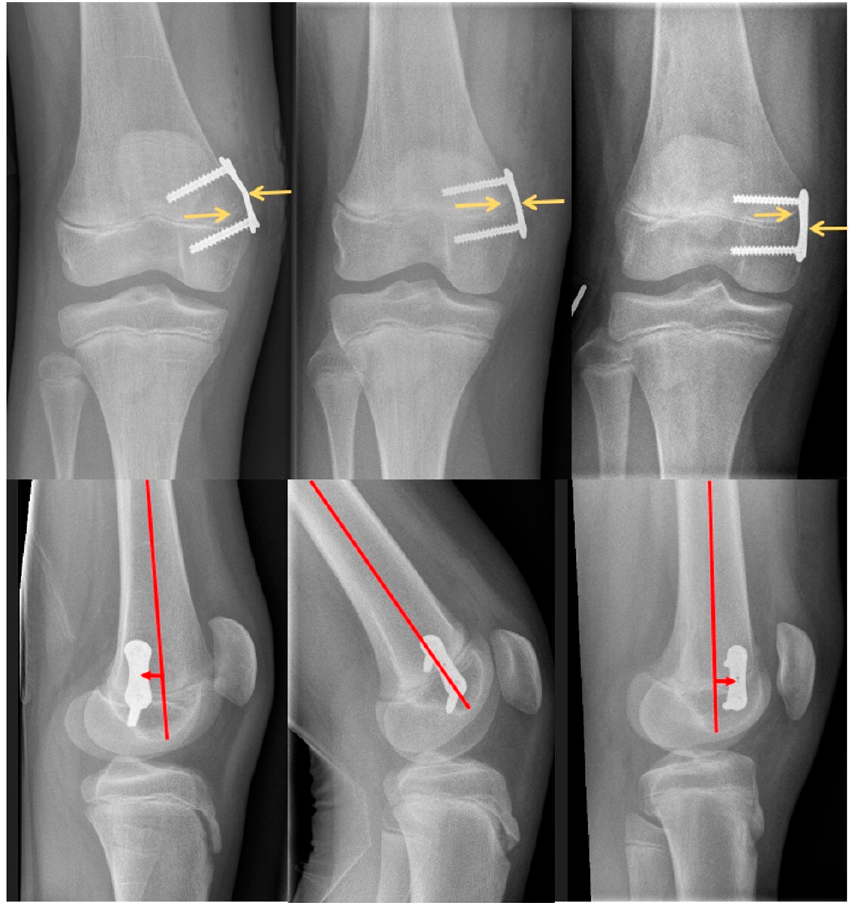
Figure 3. Radiological evaluation of the plate position: top row—plate position in relation to the physis, left arrow pointing at the center of the physis and right arrow pointing at the center of the plate) ( left image: metaphyseal position, center image: centered position, right image: epiphyseal position); bottom row—plate position in relation to the center of the shaft axis, arrow pointing in the direction of insertion ( left image: posterior position, center image: centered position, right image: anterior position).